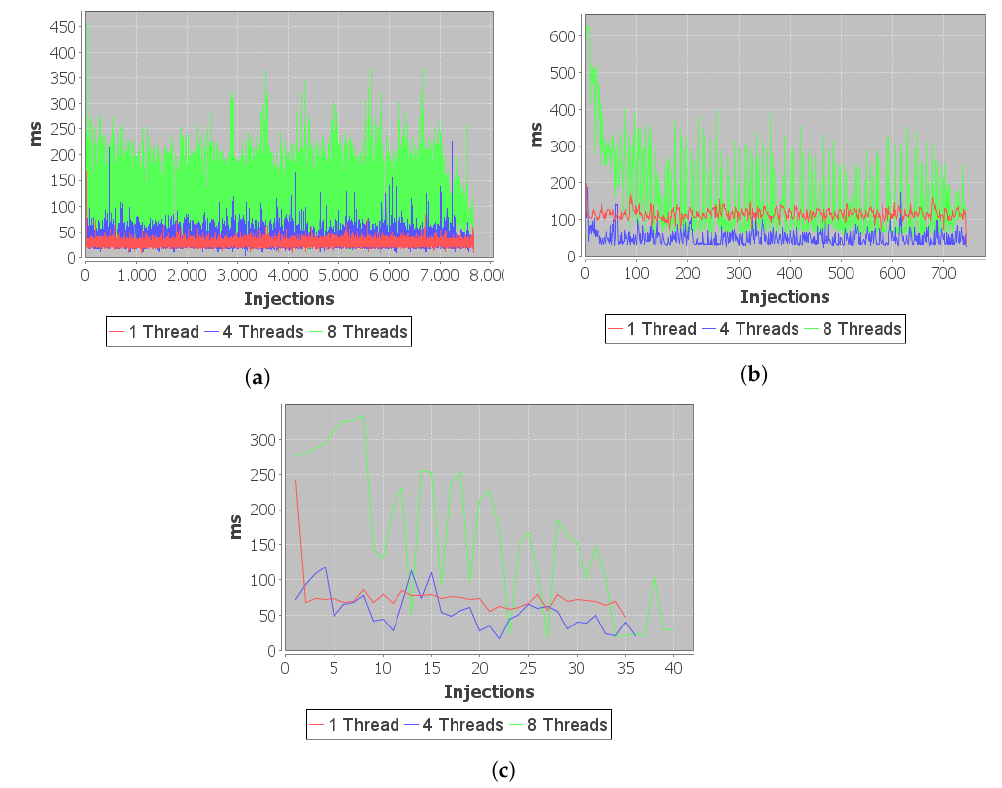
Figure 5. Sequential and concurrent dataset injections. Injection time in ms (milliseconds). ( a ) Dataset-1 Injections. ( b ) Dataset-2 Injections. ( c ) Dataset-3